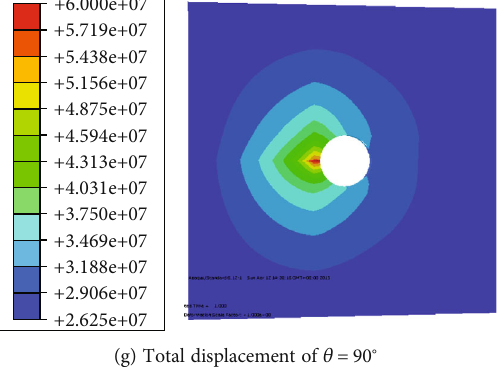
Figure 8: Pore pressure nephogram under di ff erent perforation